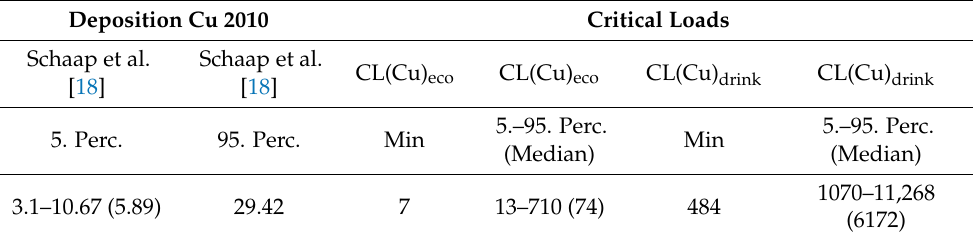
Table 10. Comparison of the 2010 Cu deposition (in g ha − 1 a − 1 ) with the critical loads (in g ha − 1 a − 1 ) of the receptor surfaces in